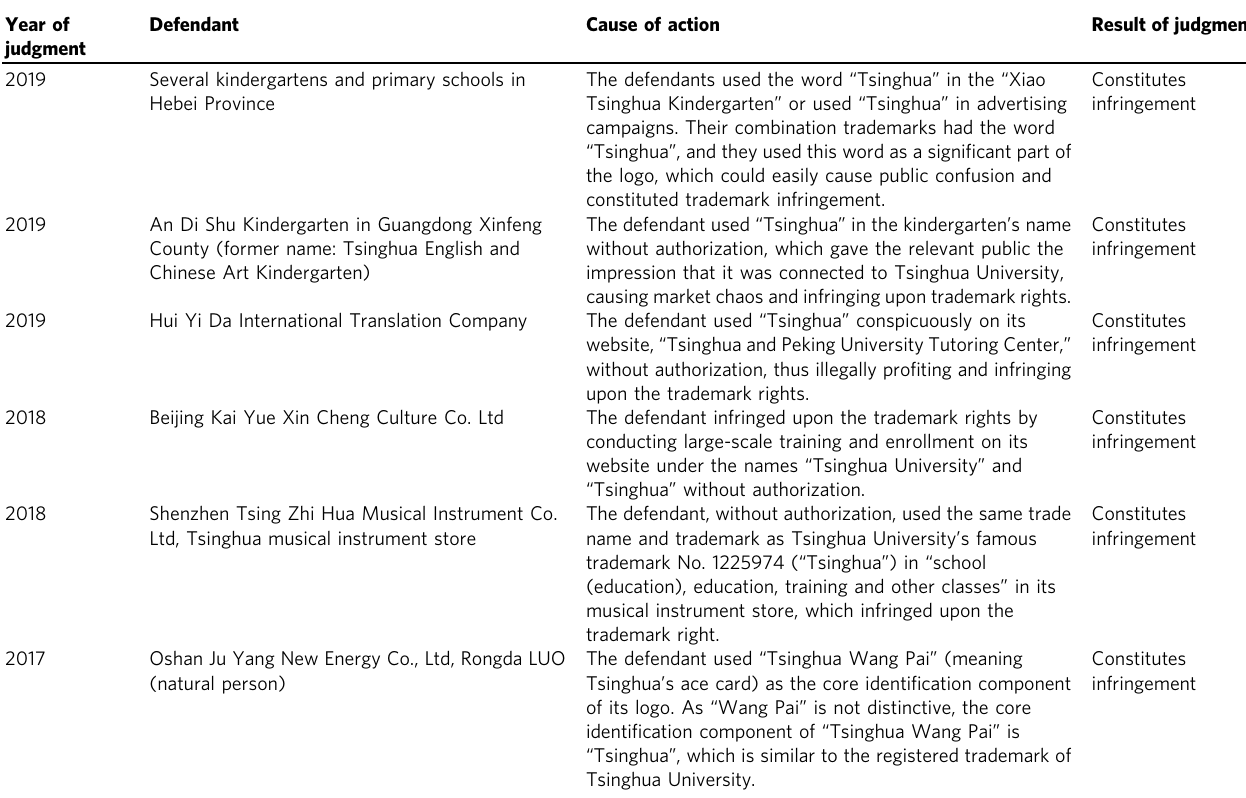
Table 6 Tsinghua university lawsuits for trademark